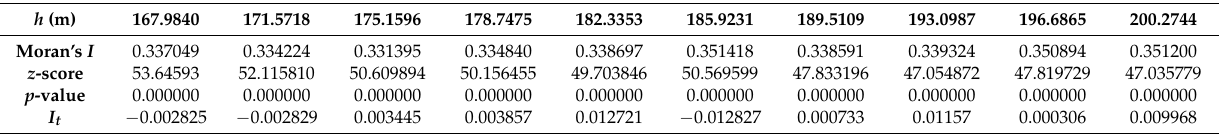
Table 3. Result of Moran’s I calculation according to cluster size at level 9.